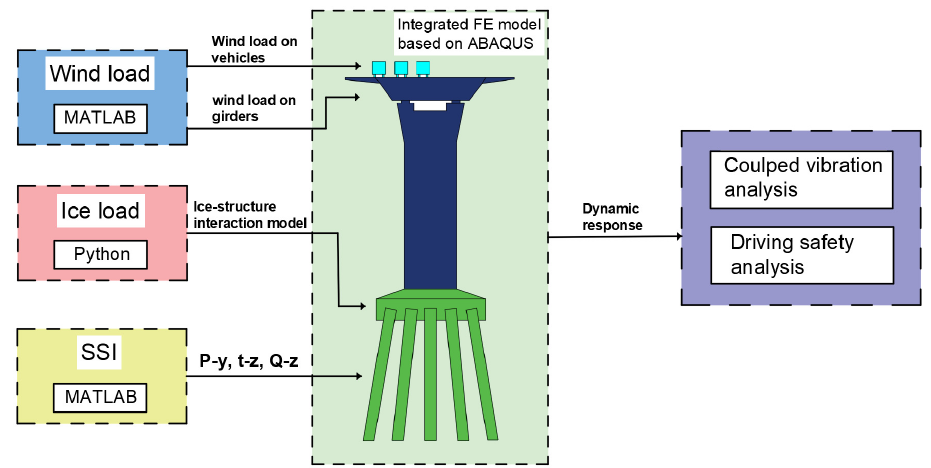
Figure 1. Schematic of simulation process for ice–wind–vehicle–bridge interaction.